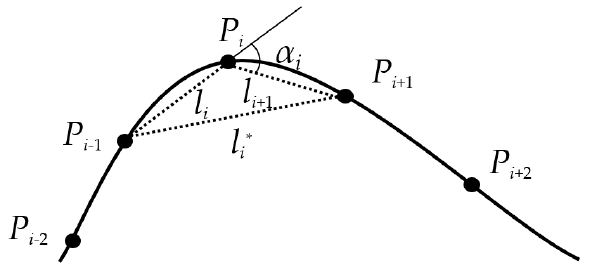
Figure 2. Feature points of curve.